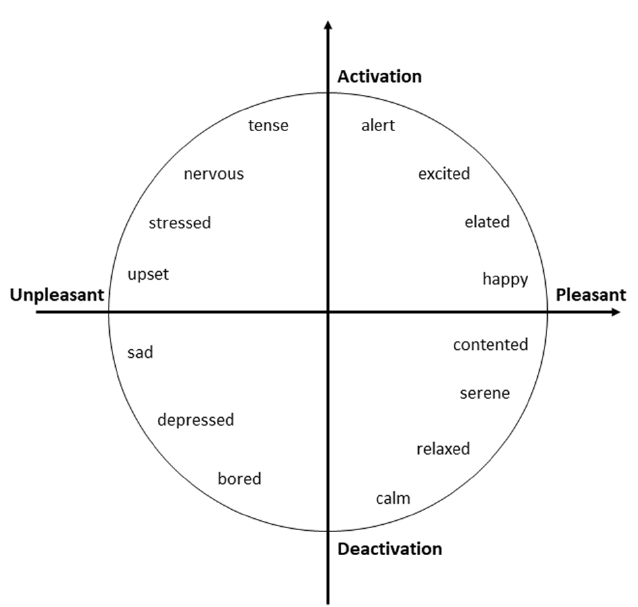
Figure 2. Circumplex Model of Affect.